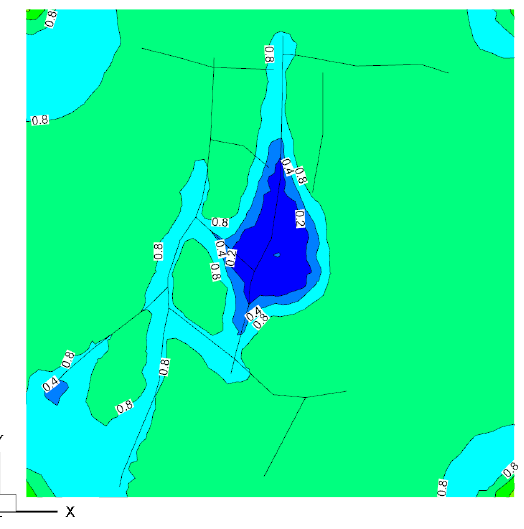
Figure 19. Permeability ratio at the top layer after 30 days’ gas